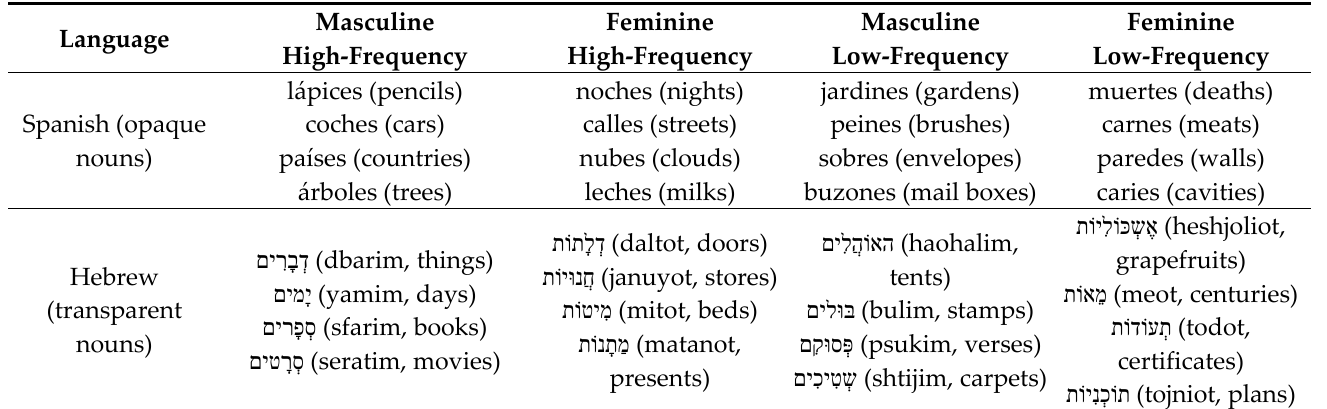
Table 8. Target nouns for tasks.